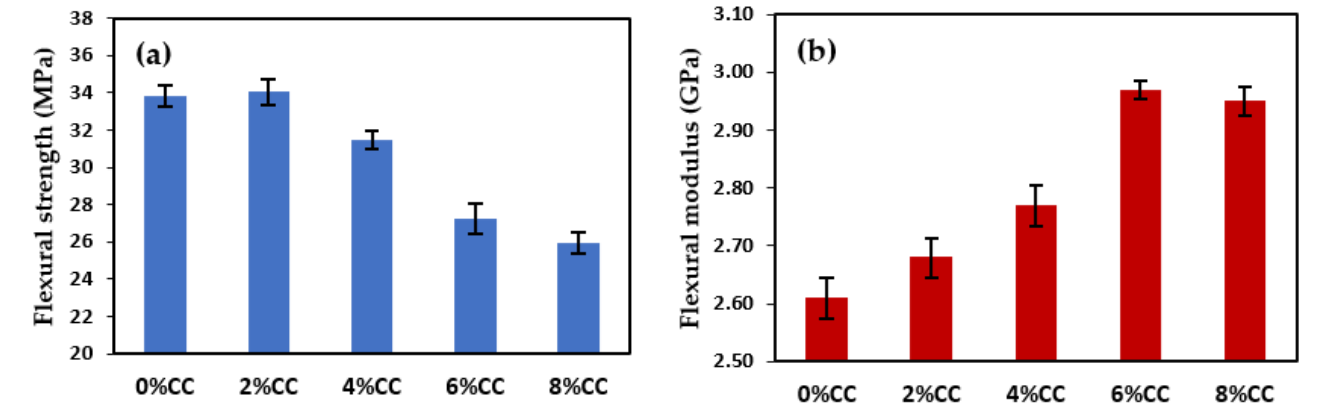
Figure 8. Effect of filler loadings on the 3D printed specimen: ( a ) Flexural strength; and ( b ) Flexural modulus.